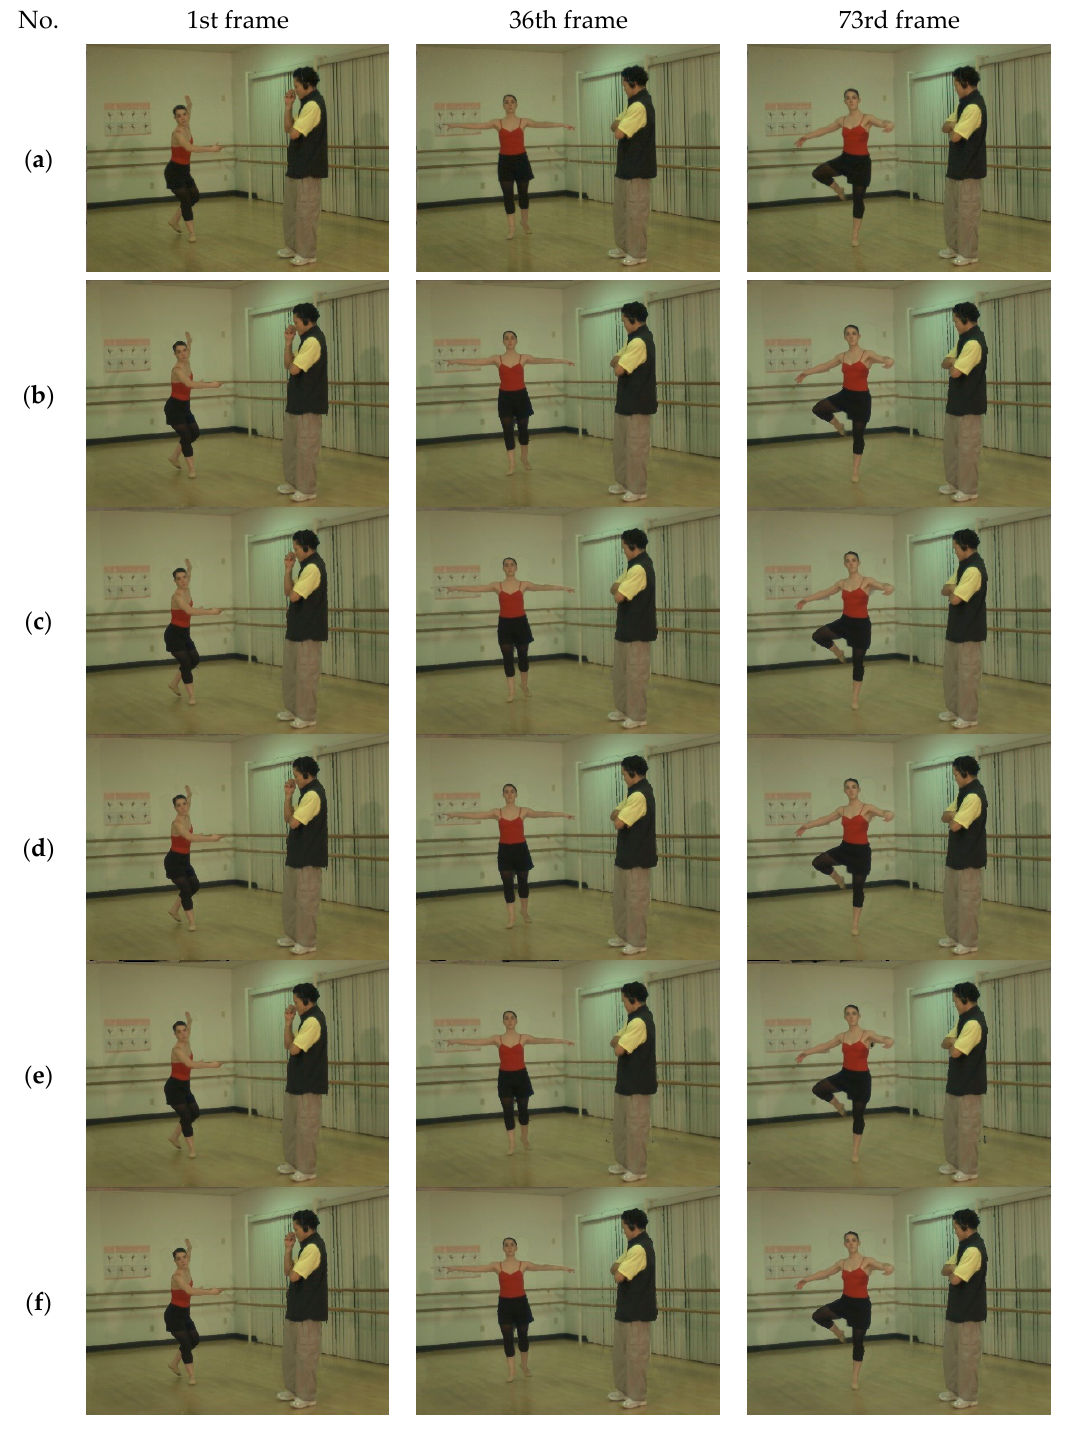
Figure 18. Synthesized virtual view for 1st, 36th, and 73rd frames on Ballet dataset. ( a ) Ground truth of Camera 4 of ( b ) Our proposed method. ( c ) Chang et al.’s method [21]. ( d ) Cho et al.’s method [19]. ( e ) Luo and Zhu’s method [26]. ( f ) Oliveira et al.’s method